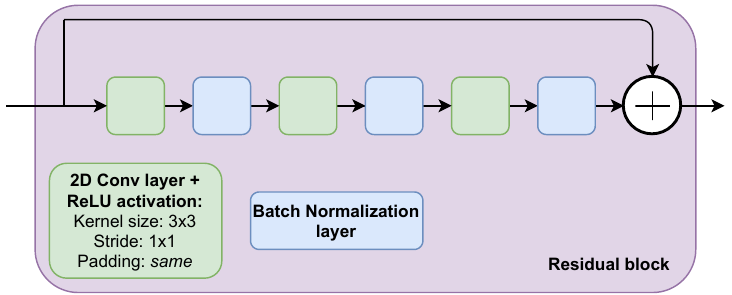
Figure 8. In-detail structure of the residual blocks in the model by Choi et al. [5].